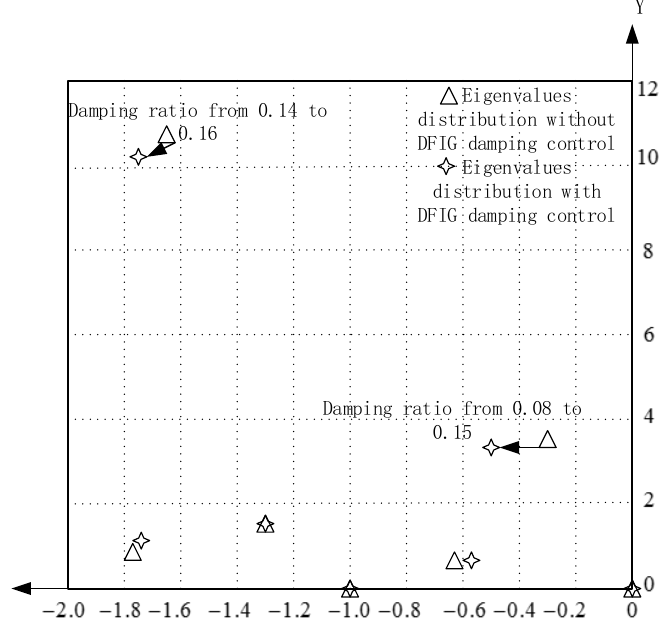
Figure 4. Change of eigenvalues with damping control.